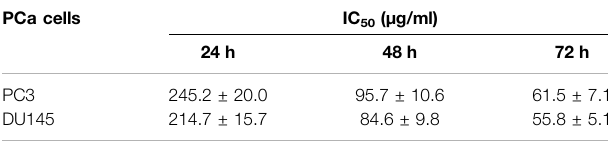
TABLE 2 | The IC 50 value of TFLS on PCa